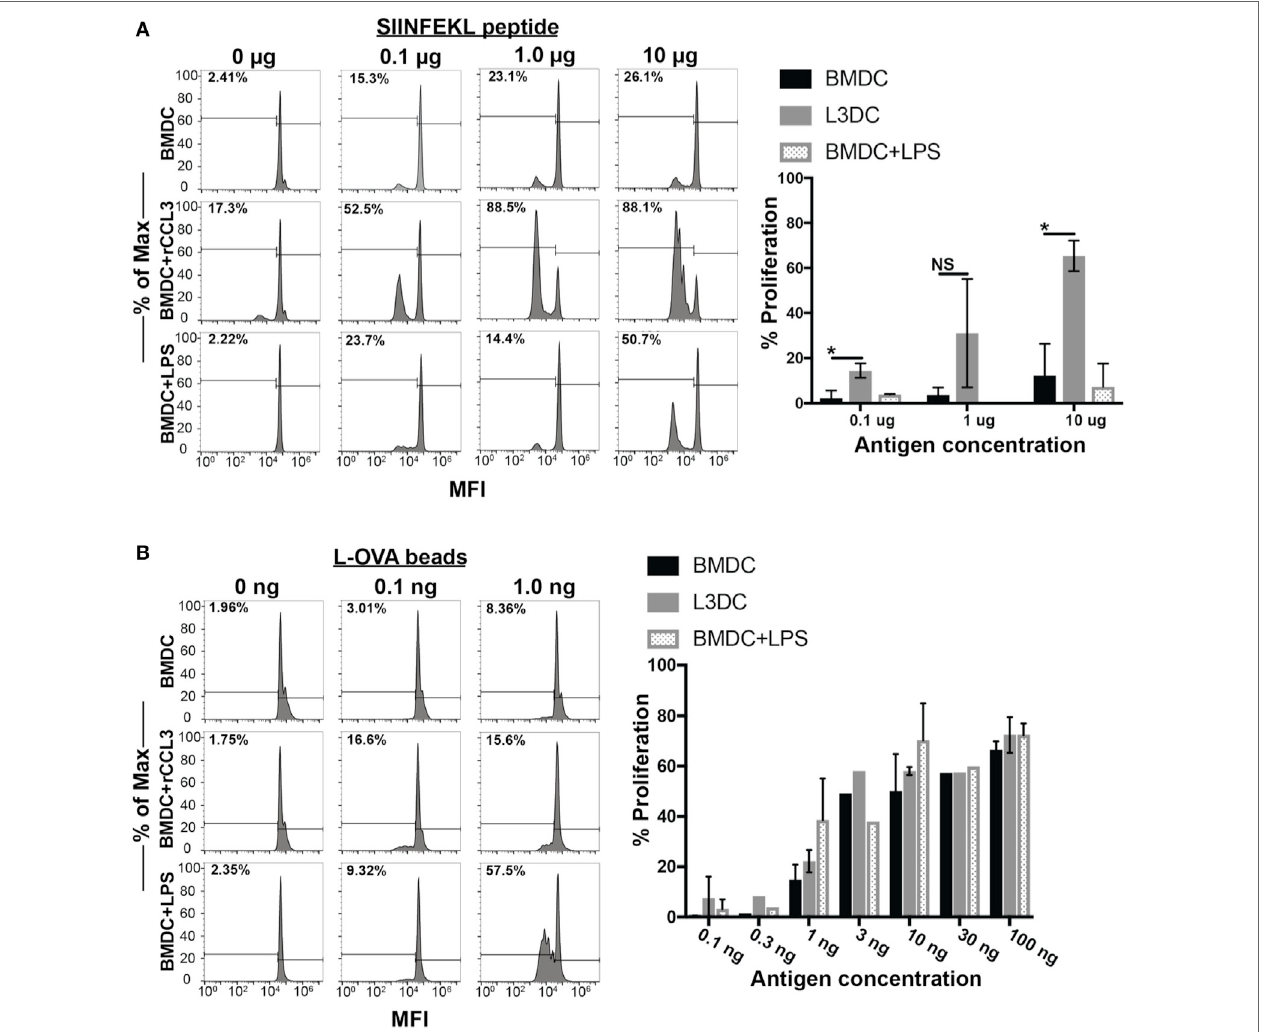
FigUre 6 | Pretreatment with recombinant CCL3 (rCCL3) enhances the capacity of bone marrow-derived DCs (BMDCs) to drive OT-I proliferation in vitro . (a) Day 7 BMDCs were cultured for 24 h in the presence or absence of CCL3 (100 ng/ml) or LPS (100 ng/ml), then washed and pulsed with the indicated concentration of SIINFEK peptide, and plated in the presence of CFSE-labeled (1 μ M) naive OT-I T cells at 1:5 BMDC-to-T cells ratio for 72 h. A total of three independent experiments were performed. (B) Day 7 BMDCs were cultured for 24 h with media, 100 ng/ml rCCL3 or LPS (100 ng/ml), then washed and incubated with OVA-latex beads at varying concentrations with CFSE-labeled (1 μ M) naïve OT-I T cells at 1:5 BMDC-to-T cells ratio for 72 h. Quantification of FACS data in (a,B) are summarized in the bar graphs. Quantification of results in (a,B) . Each bar was calculated after subtracting the background CFSE dilution in the absence of added antigen. Each graph is representative of three to four experimental replicates. Not significant (ns), p > 0.05; * p = 0.01–0.05; ** p = 0.001–0.01; *** p = 0.0001–0.001; **** p <